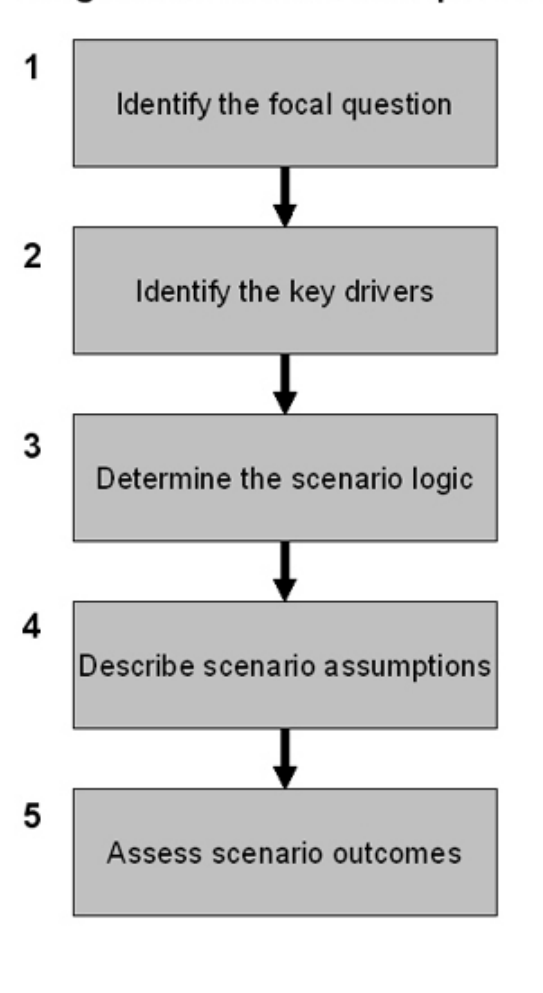
Fig. 1. Five common stages of scenario development, based on the eight steps defined by Schwartz